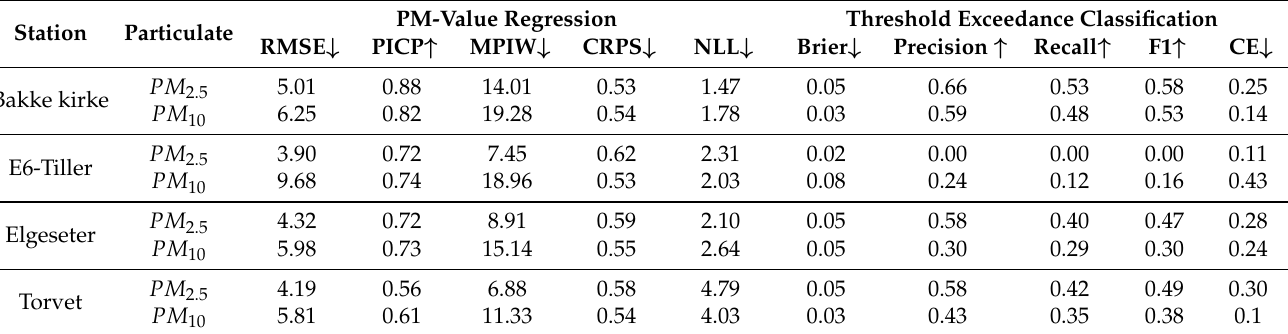
Table 5. Summary of performance results when forecasting PM-value or threshold exceedance using an LSTM model with MC dropout.